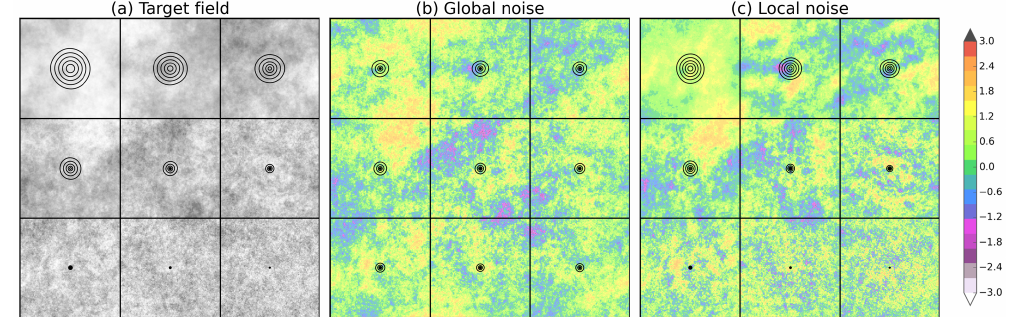
Figure 4. (a) An example of 512px × 512px non-stationary correlated Gaussian noise generated using parametric filtering. The spectral slope β increases from − 3.0 to − 1.5 from the top towards the bottom of the image as represented by black contours at 0.5, 0.6, 0.7, 0.8 and 0.9 correlation coefficients. Non-parametric stochastic realisations of the target field using a global generator (b) and a local SSFT generator (c) with Hanning windows centred over the grid boxes in the image. All simulations have been drawn from the standard normal distribution and share the same random seed.